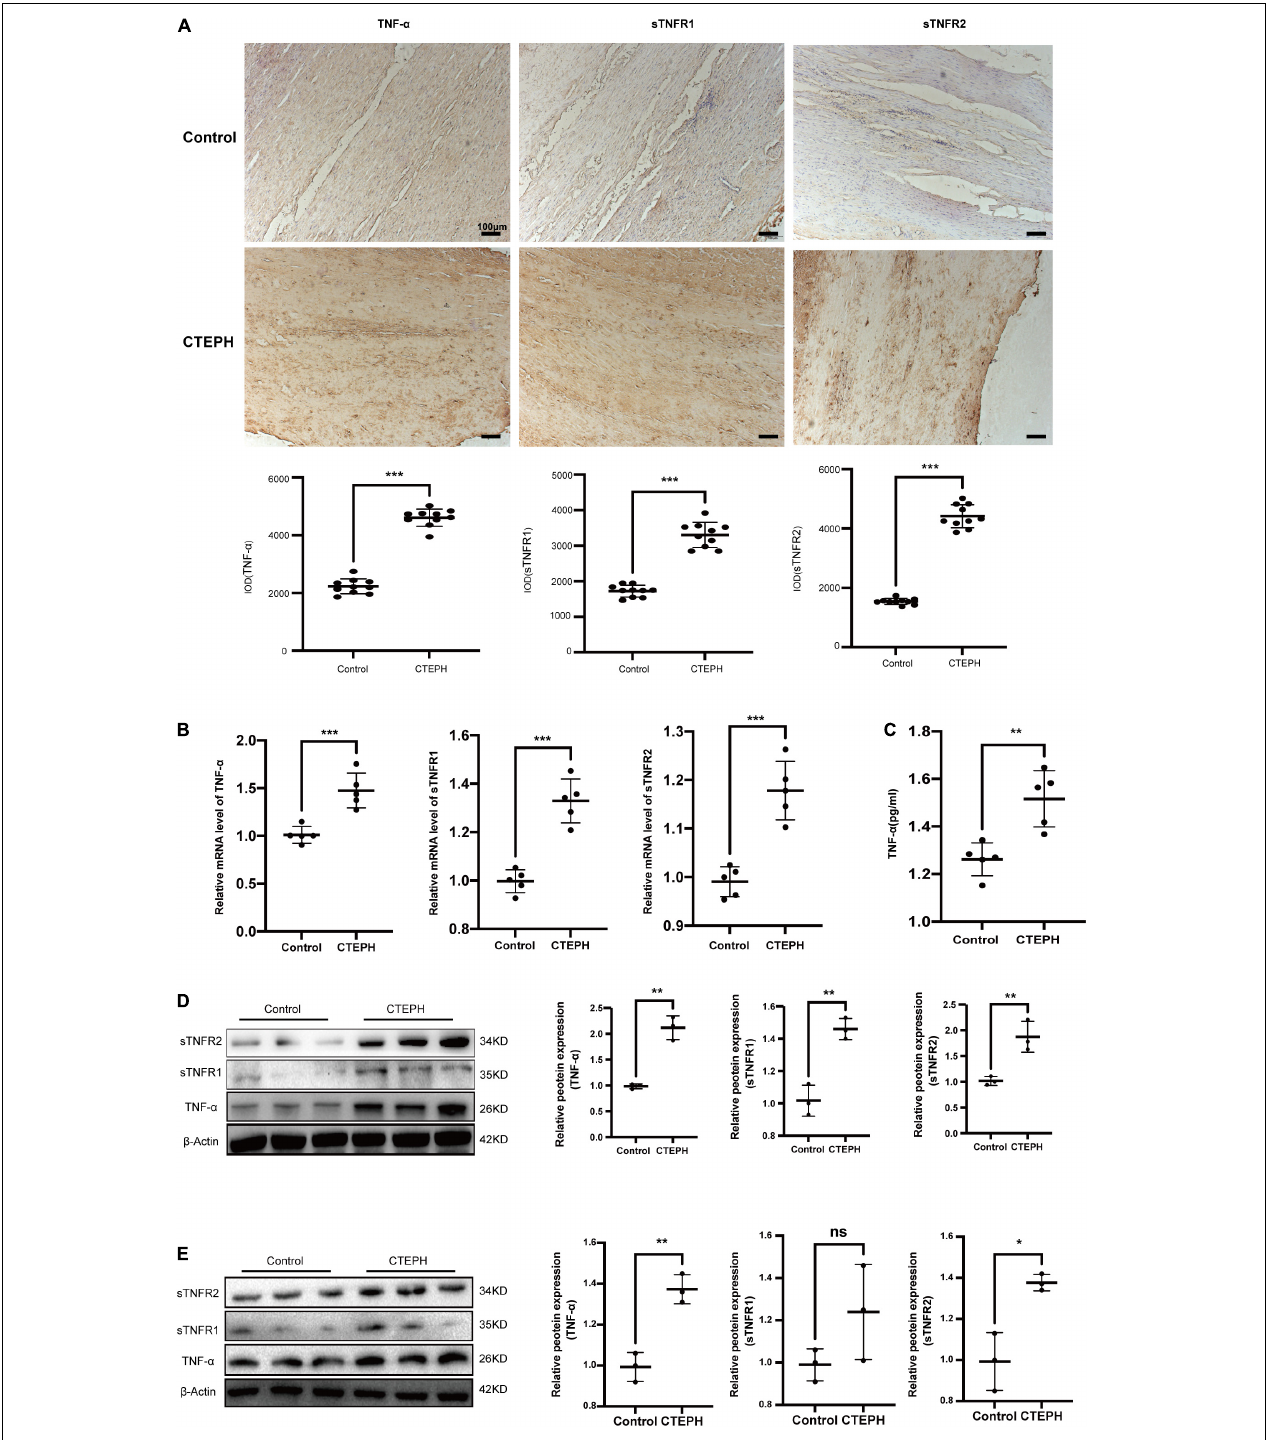
FIGURE 6 | Increased expression of TNF- α in CTEPH group. The expression of TNF- α , sTNFR1 and sTNFR2 were increased in CTEPH group using immunocytochemistry (A) and PCR (B) , and the corresponding quantitative analysis, n = 10 or 5, results are expressed as the mean ± SD, *** p < 0.001. The circulating TNF- α level in the control group and CTEPH group were measured by Elisa assay. The result demonstrated TNF- α level was higher in the CTEPH group comparing with those in the control group. N = 5, results are expressed as the mean ± SD, ** p < 0.01 (C) . The expressions of TNF- α , sTNFR1 and sTNFR2 in vascular tissues and primary VSMCs from two groups measured by Western blot (D) . Consistent with the PCR results, the expressions of TNF- α , sTNFR1, and sTNFR2 were significantly higher in CTEPH group compared with control group, n = 3, results are expressed as the mean ± SD. ns represent no significantly change, * p < 0.05, ** p < 0.01 (E) . Data were analyzed using student t -test.